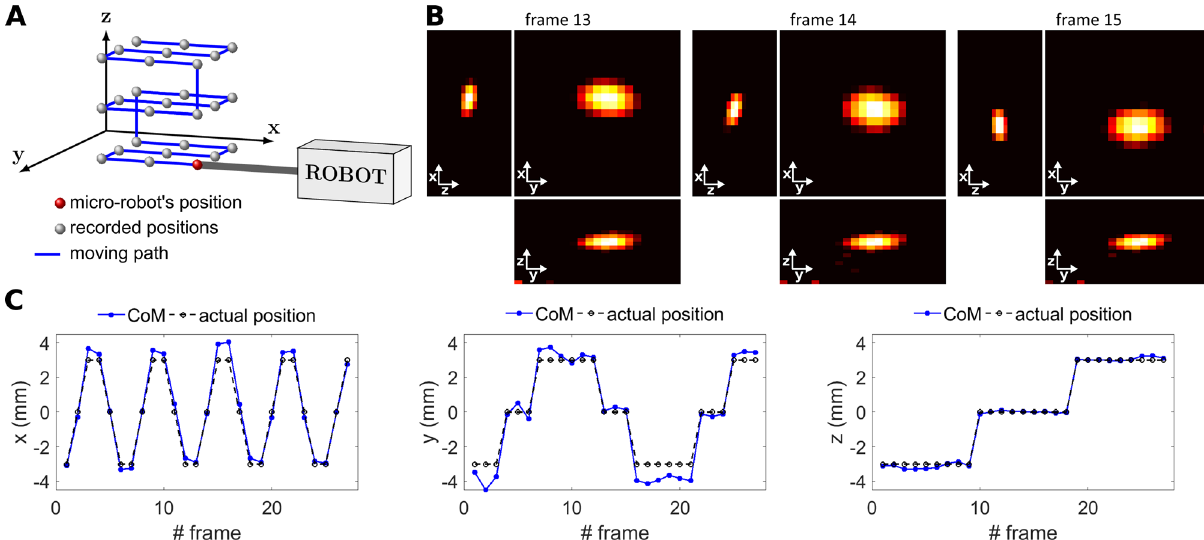
Figure 3. Tracking accuracy for the micro-robot with MPI. ( A ) Robot movement for the acquisition of 27 spatial positions of the micro-robot. ( B ) Visualization of the micro-robot exemplarily at three different positions. Projection images for each spatial direction are shown. ( C ) The center-of-mass (CoM) calculation for 27 different positions, compared to the actual position of the micro-robot. A mean deviation of 0.68 mm and maximum deviation of 1.5 mm between the CoMs and the actual position were